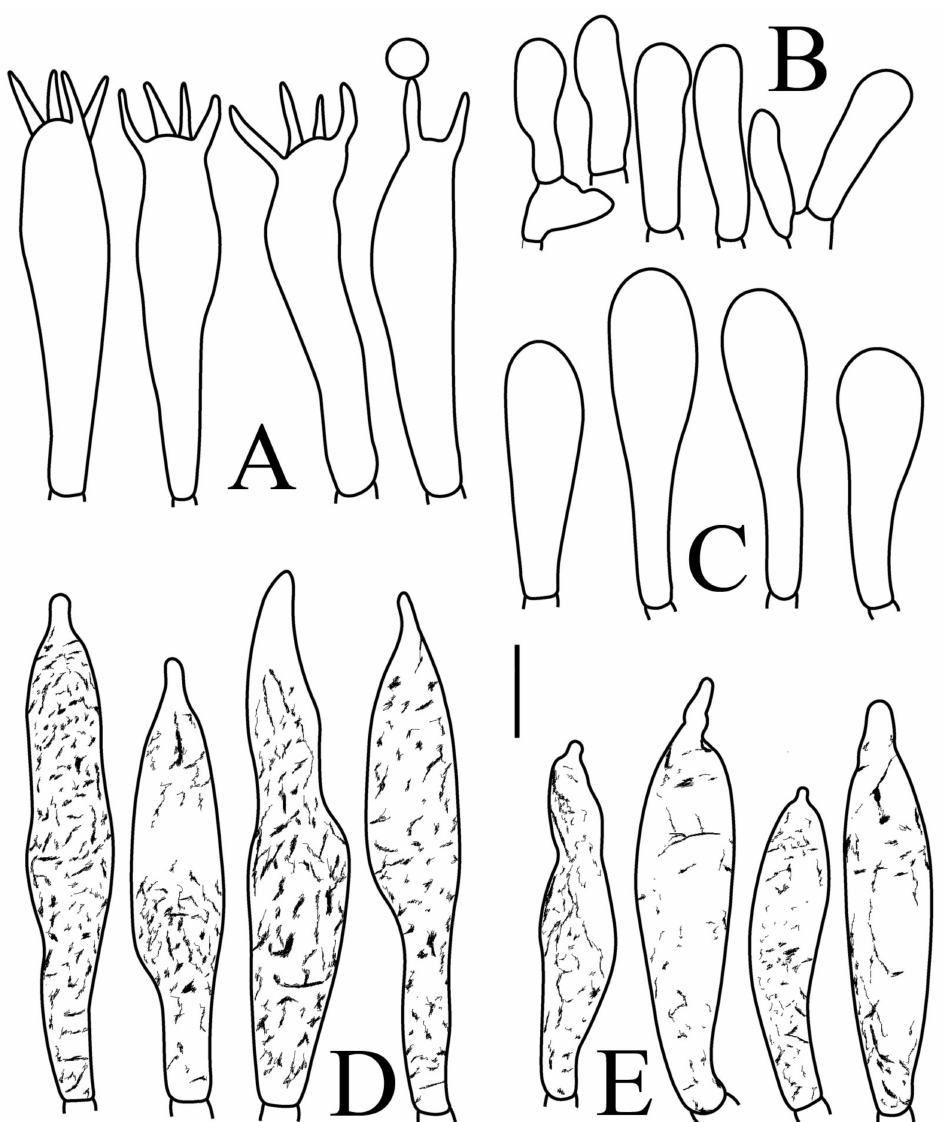
Figure 4. Russula brevispora. (HGASMF-009915, holotype): ( A ) basidia; ( B ) marginal cells; ( C ) basidiola; ( D ) hymenial cystidia on lamellae sides; ( E ) hymenial cystidia on lamellae edges. Scale bars: 10 µ